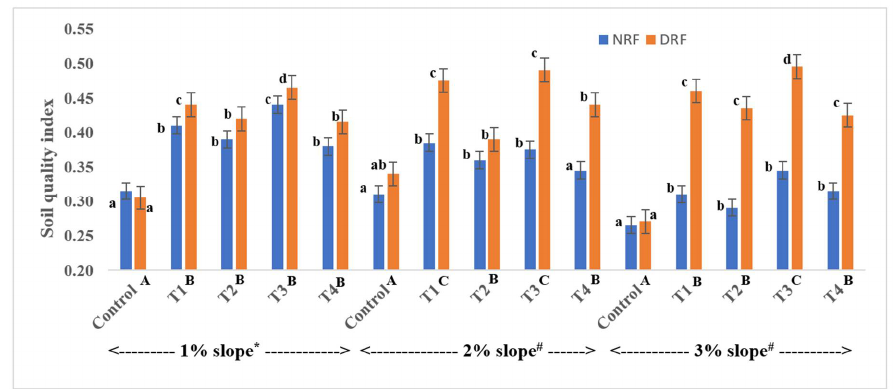
Figure 3. Effect of grass strip treatment on soil quality index across variable slopes (1–3%) in two different rainfall situations. ABC differ significantly at a 1% level of significance between the treatments, irrespective of slope. abcd differ significantly at a 5% level of significance between the treatments within a particular slope level at different rainfall situations. * # differ significantly at a 5% level of significance between the slopes. T1, top and bottom Stylosanthes strip; T2, only bottom strip of Stylosanthes ; T3, top and bottom Brachiaria strip; T4, only bottom strip of Brachiaria.